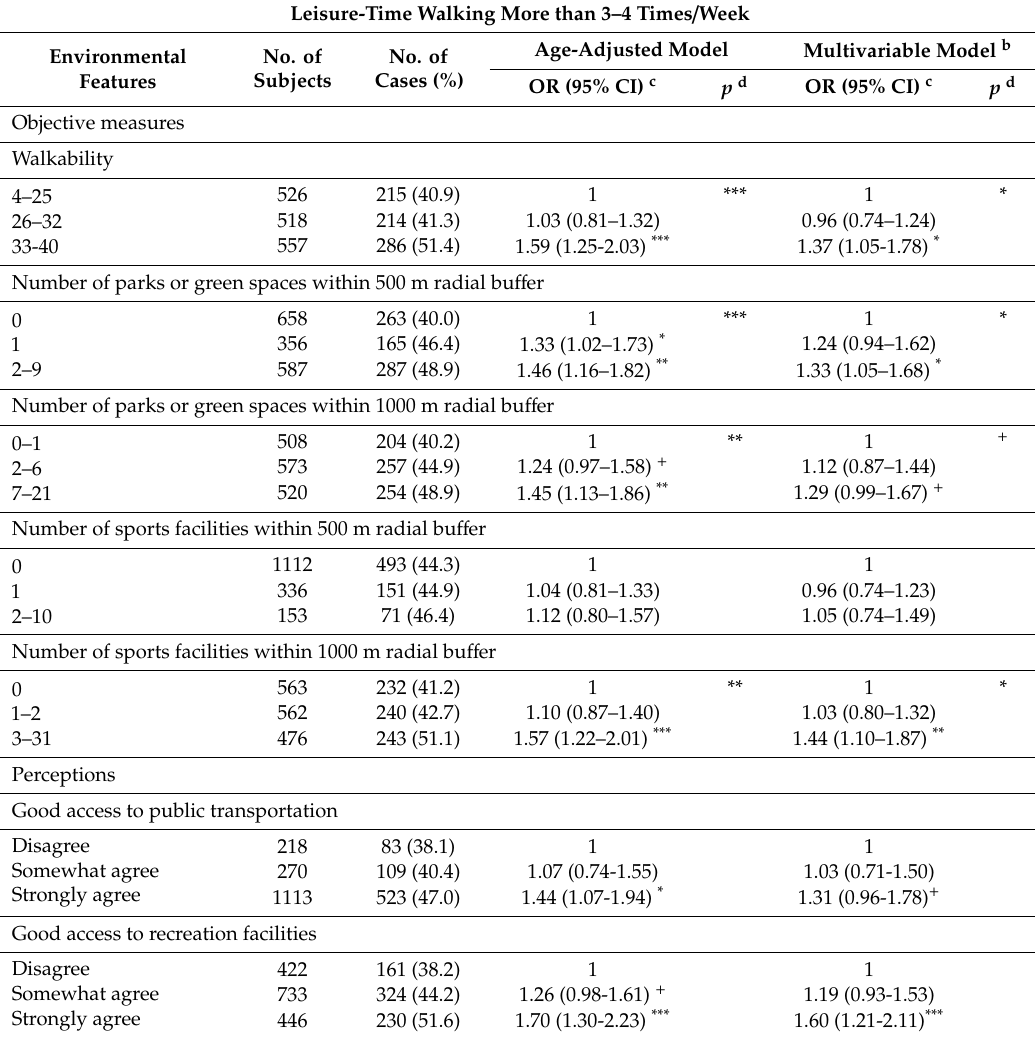
Table 2. Odds ratios for walking habits a according to built neighborhood environmental features among retired civil servants, Aichi Worker’s Cohort,